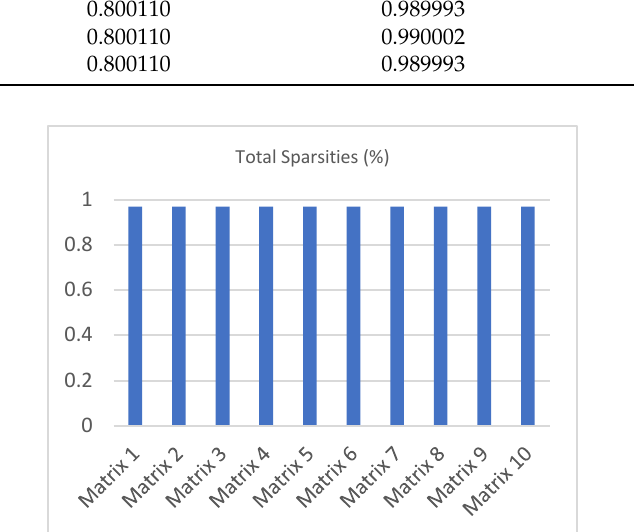
Figure 4. Matrices total sparsity information.